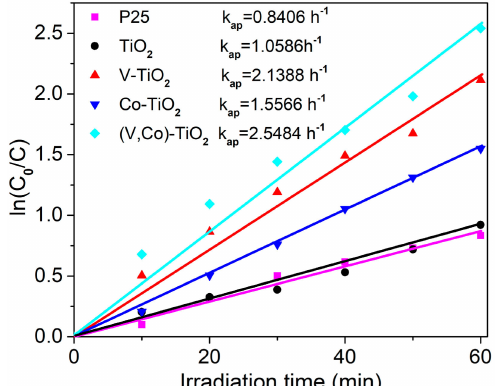
Figure 10. The kinetics of MB photocatalytic degradation over the P25, TiO 2 , V–TiO 2 , Co–TiO 2 , and (V,Co)–TiO 2 samples.